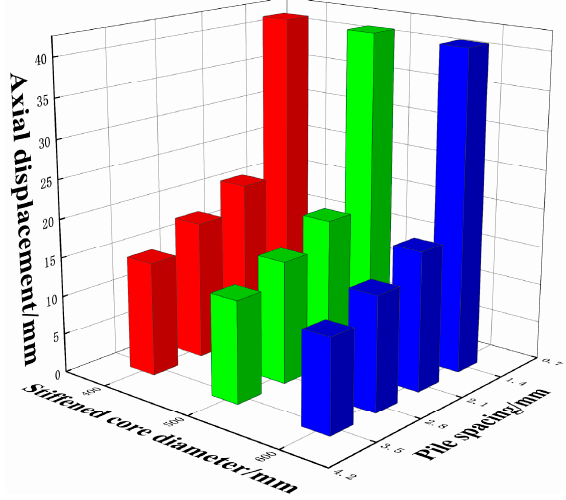
Figure 20. Influence of stiffened core diameter and pile spacing on settlement.